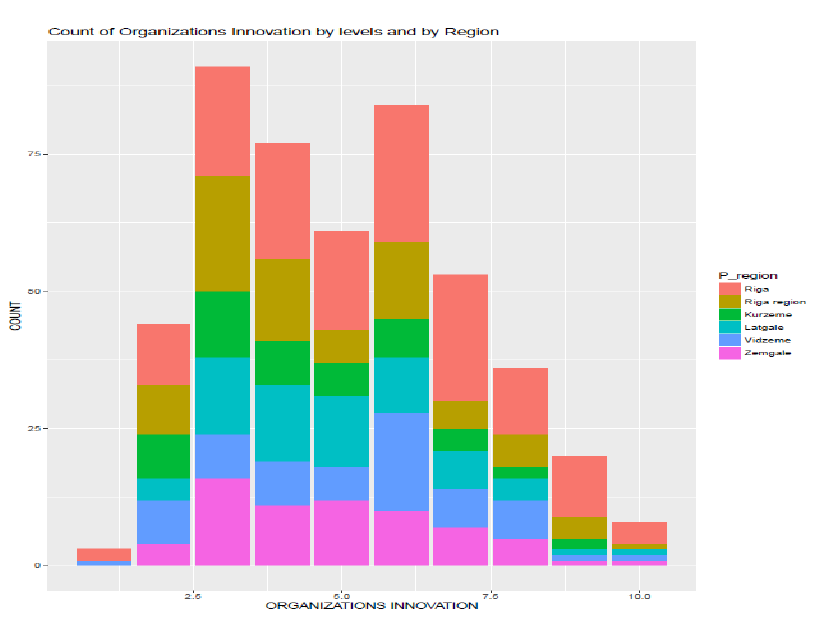
Fig. 5. Bar chart of OI by region obtained through R programming language. Source: authors’